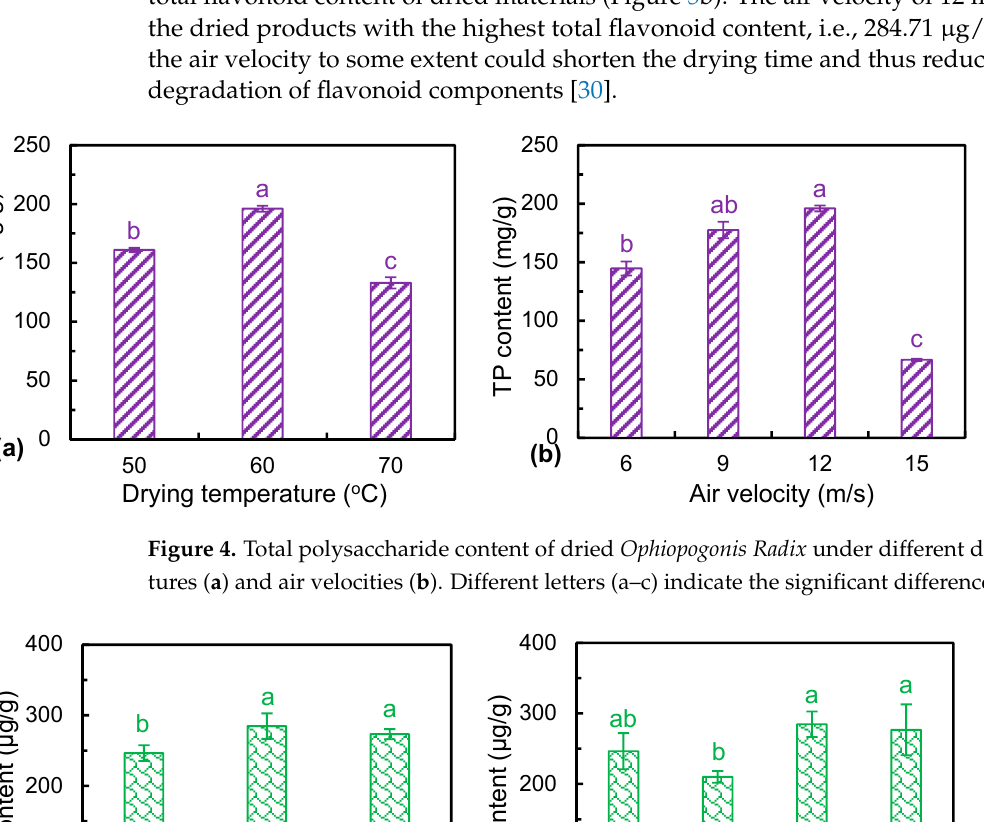
Figure 6. Rehydration ratio of dried Ophiopogonis Radix under di ff erent drying temperatures ( a ) and air velocities ( b ). The le tt er (a) indicates that there is no signi fi cant di ff erence at p < 0.05.